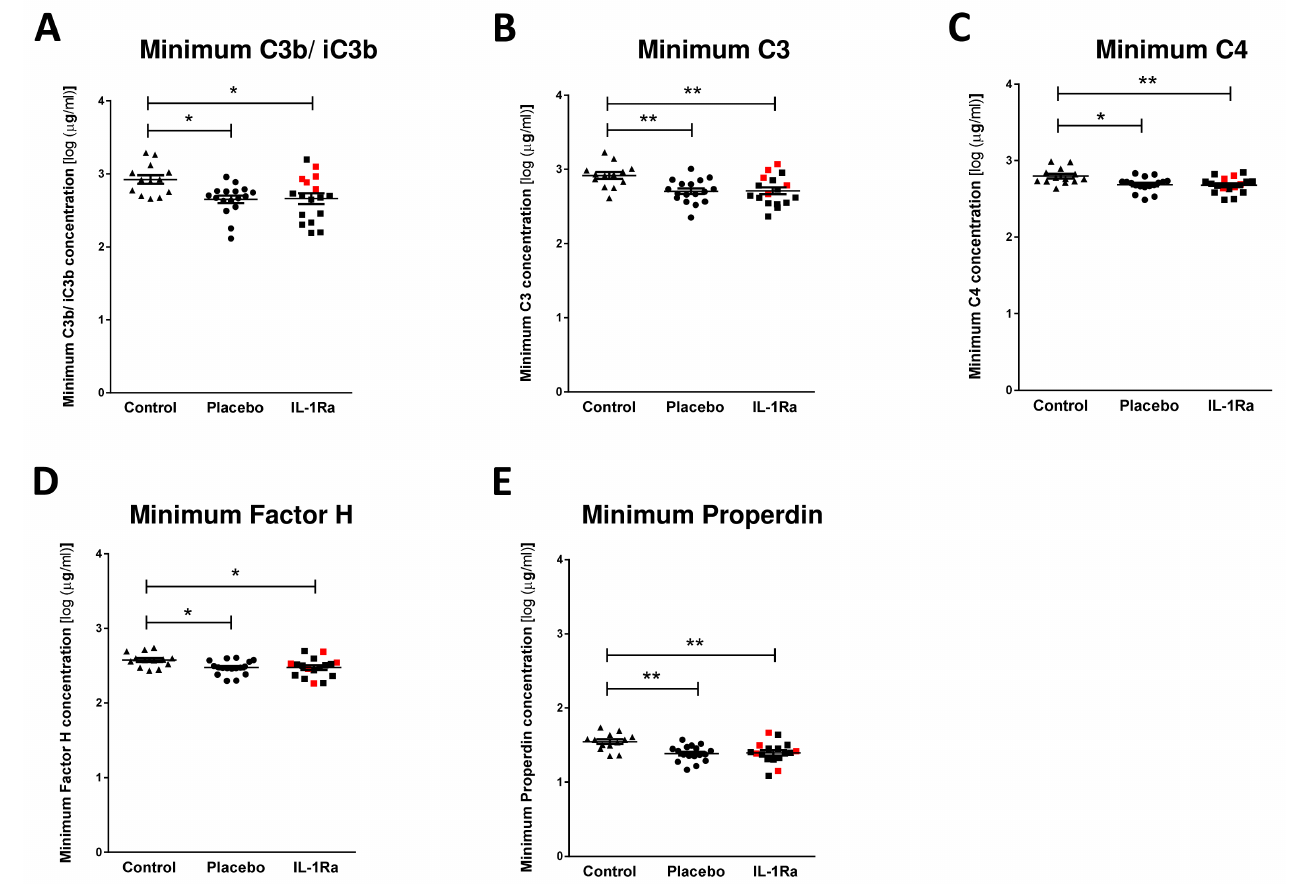
Figure 2. Treatment with IL-1 receptor antagonist (IL-1Ra) has no effect on complement components downregulated after stroke. Minimum concentrations of ( A ) C3b/ iC3b, ( B ) C3, ( C ) C4, ( D ) Factor H and ( E ) Properdin were measured in the first seven days after stroke were reduced in both placebo and IL-1Ra treated patients in comparison to healthy controls. Data show mean ±SD, * P<0.05 ; ** P<0.01 ; one-way ANOVA with Bonferonni